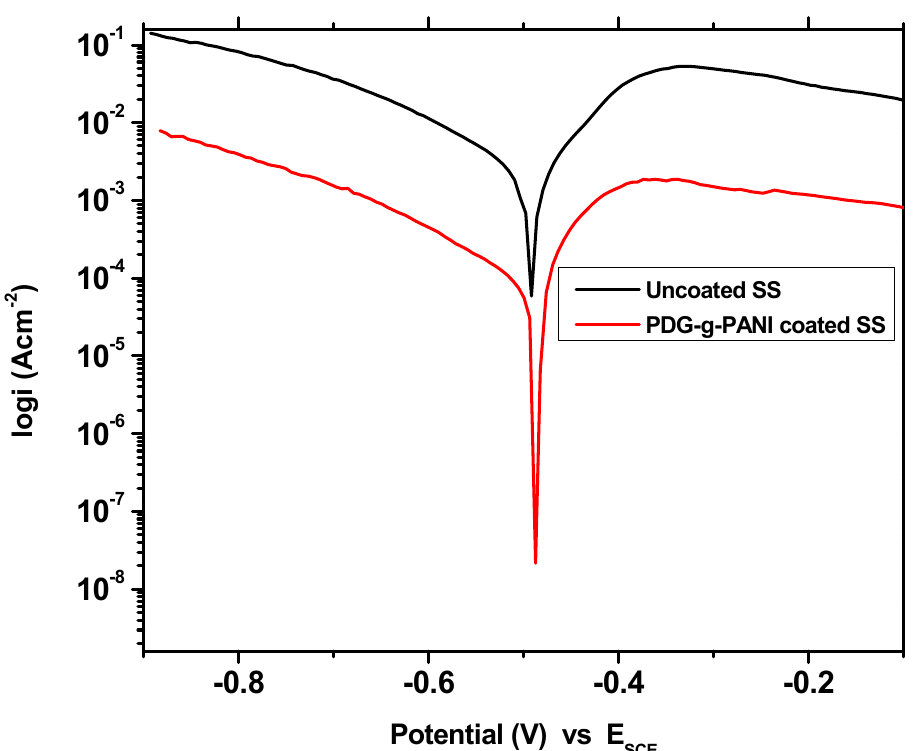
Figure 13. Tafel plot of uncoated SS and PDG-g-PANI-coated SS in 1 M H 2 SO 4 .